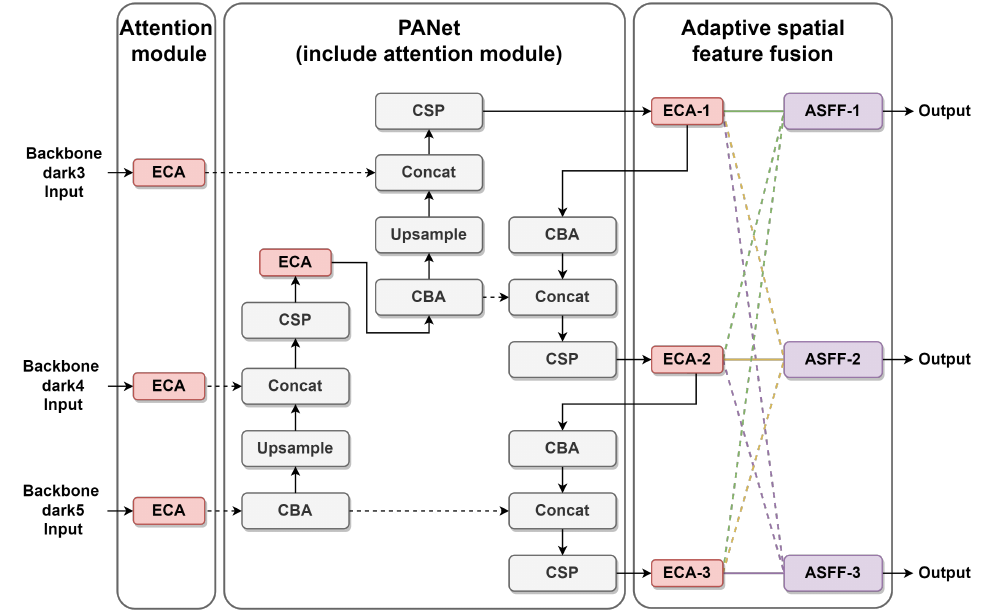
Figure 2. An overview of the feature extraction network.